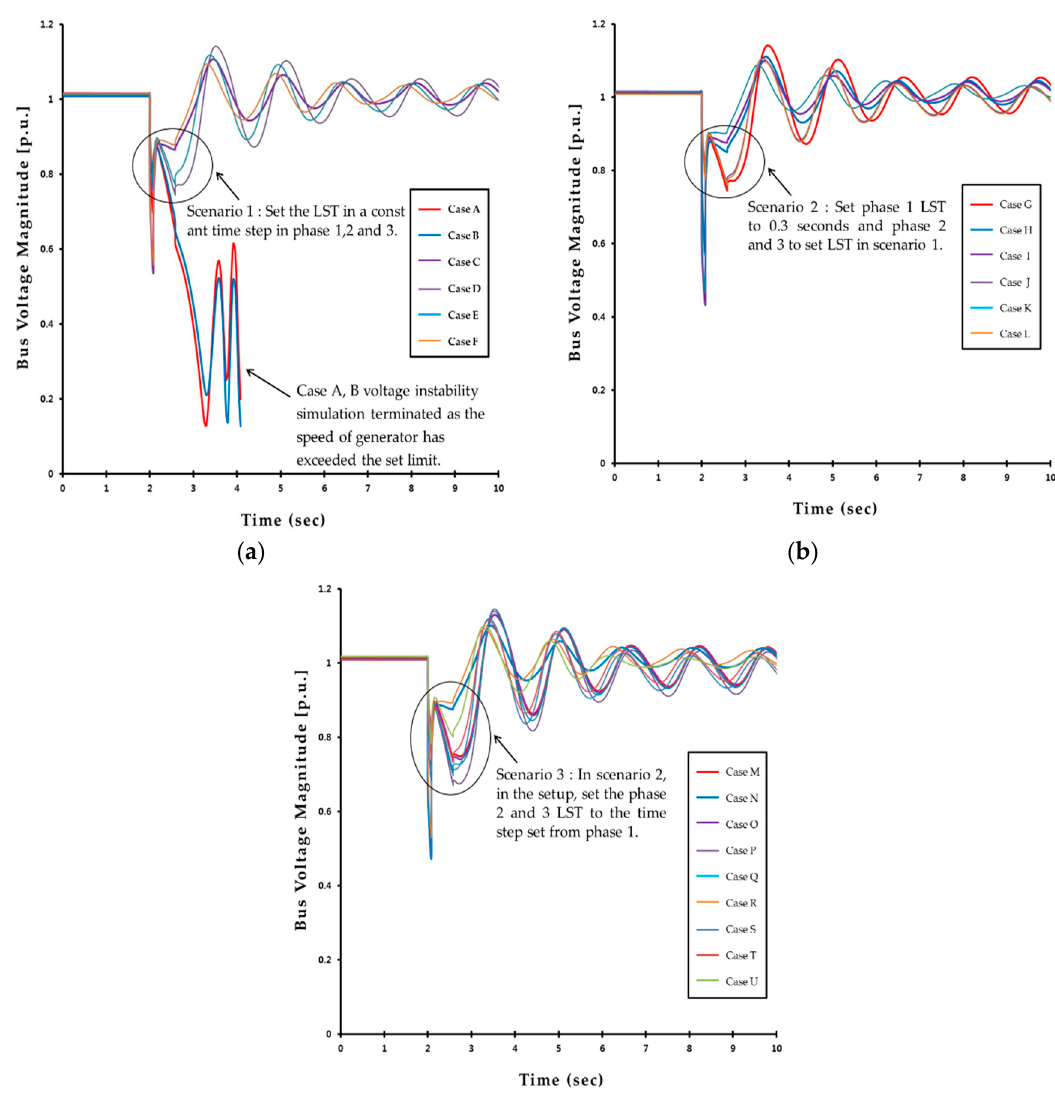
Figure 7. Results of bus voltage recovery depends on load shedding amount (LSA) and load shedding time (LST). ( a ) Scenario 1: Set the LST in a constant time step in phase 1, 2 and 3; ( b ) Scenario 2: Set phase 1 LST to 0.3 s and phase 2 and 3 to set LST in scenario 1; ( c ) Scenario 3: In scenario 2, in the setup, set the phase 2 and 3 LST to the time step set from phase 1.